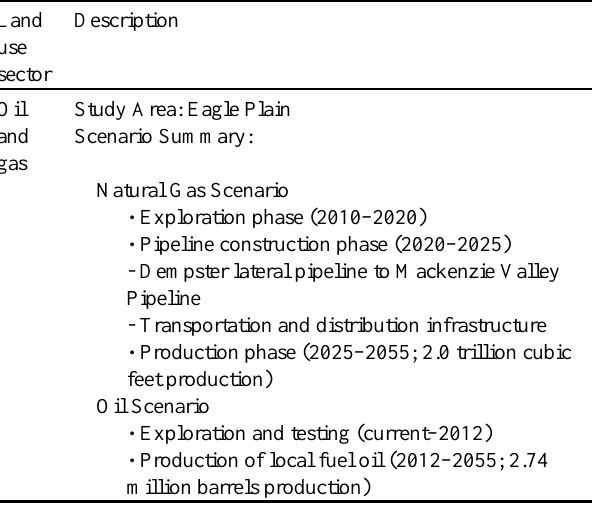
Table 2 . Overview of Eagle Plain oil and gas